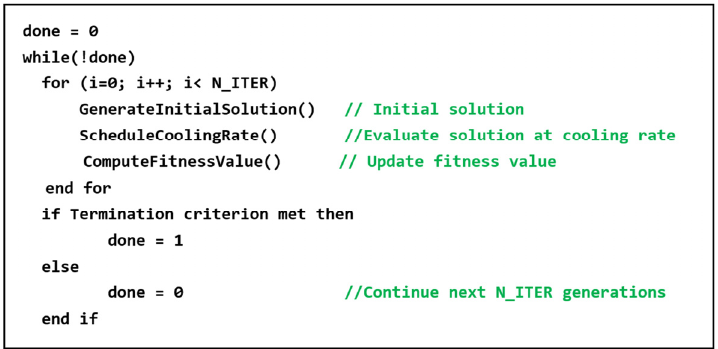
Figure 5. Simulate Annealing (SA) algorithm formulation for hybrid photonic NoC synthesis.